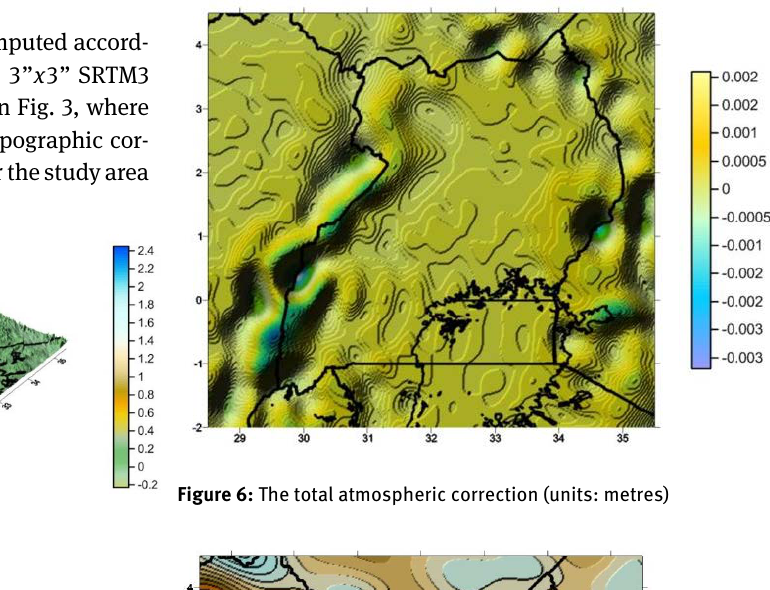
Figure 6: The total atmospheric correction (units: metres)